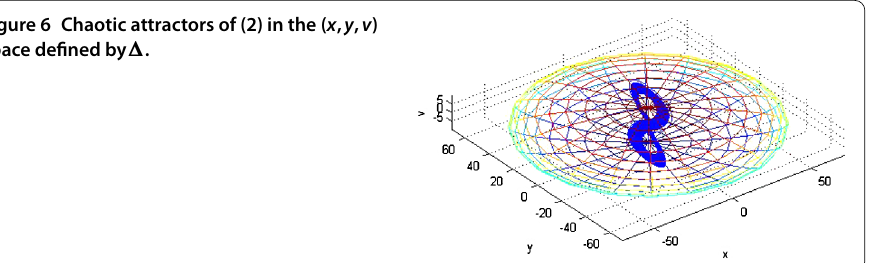
Figure 7 Chaotic attractors of (2) in the ( x , y , u ) space defined by (cid:2) .